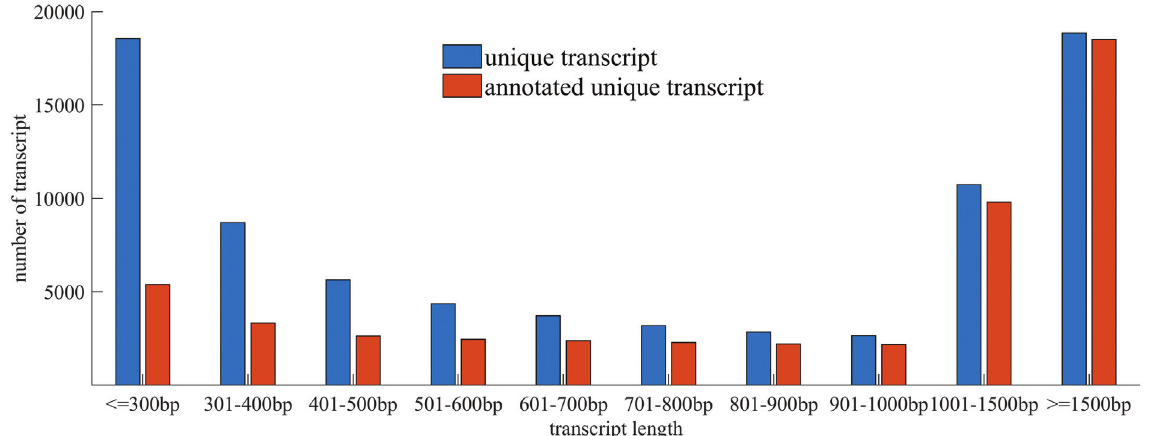
Figure 2 - Length distribution of unique Medicago ruthenica transcripts. Transcript length is shown on the X-axis, and the Y-axis shows the number of transcripts. The numbers and relative proportions of annotated transcripts increase with transcript length, implying that longer transcripts have a higher probability of being